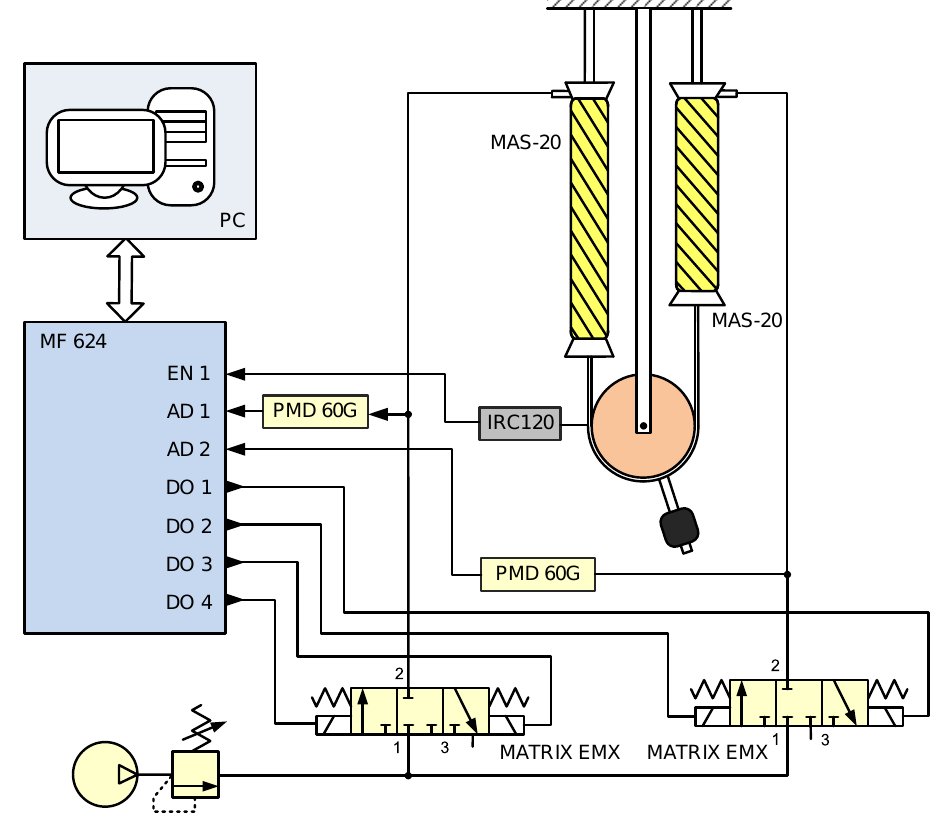
Figure 3. Schematic diagram of the experimental platform.